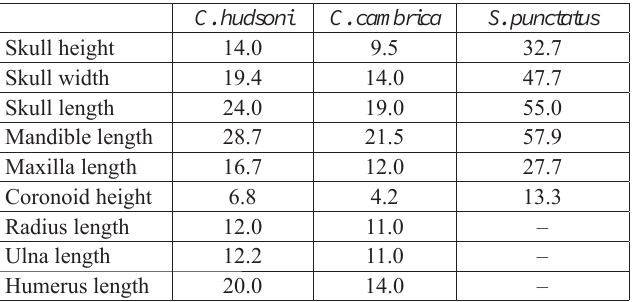
Table 1. Measurements (in mm) of Clevosaurus hudsoni (NHMUK PV R36832), Clevosaurus cambrica (NHMUK PV R37014 and NHMUK PV R37013), and Sphenodon punctatus (from Maisano 2001).